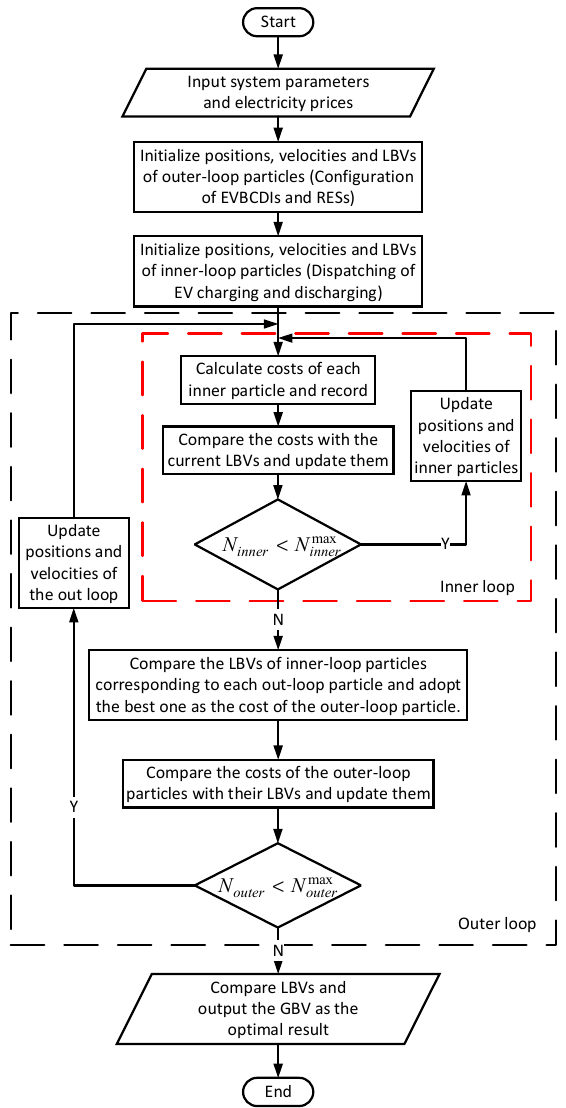
Figure 4. Process of the cooperative optimization. LBV: local best value, GBV: global best value.